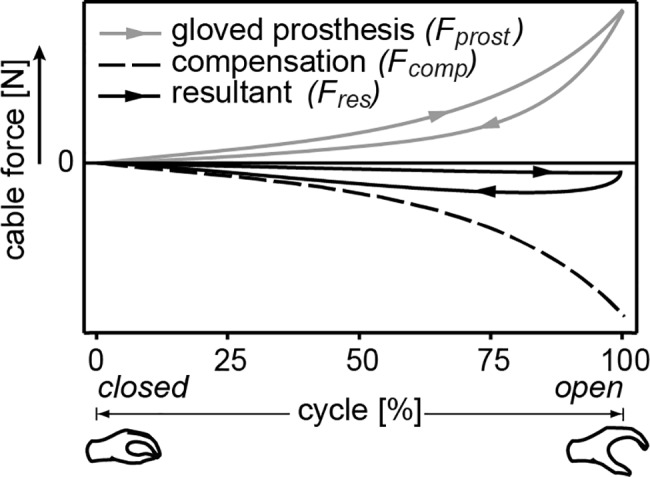
An ideal case of overcompensation of the glove characteristic.The operation of the resultant characteristic is reversed and turns an otherwise voluntary opening device into a voluntary closing device.